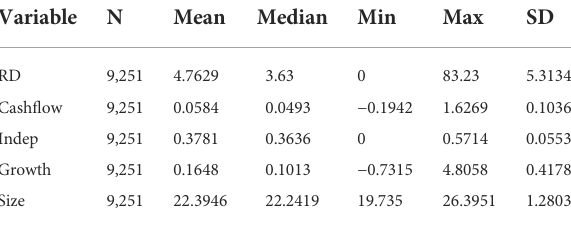
TABLE 3 Descriptive statistics of the dependent variable RD.